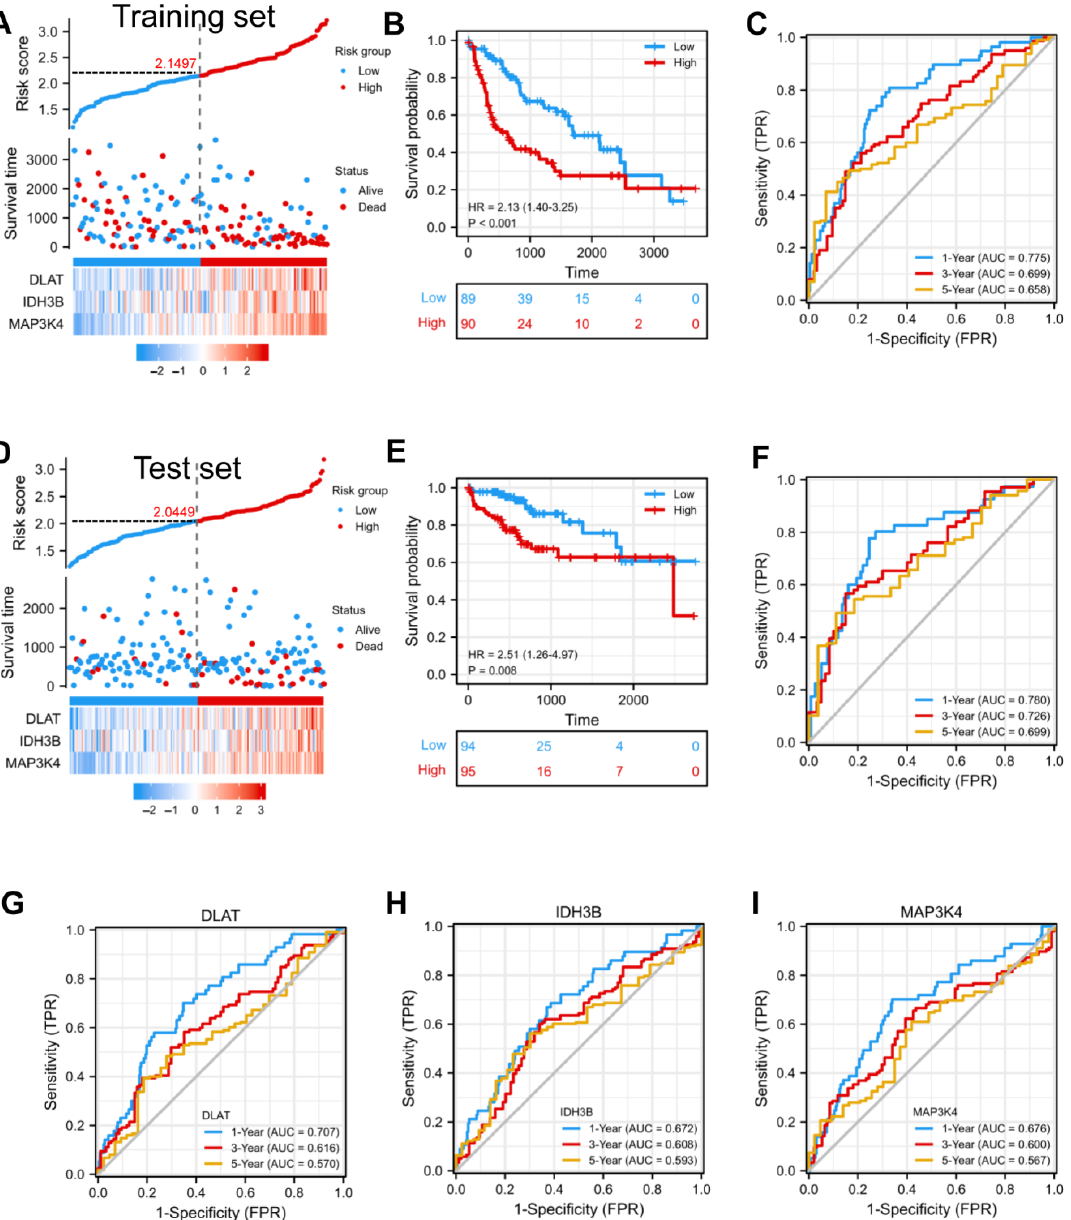
Figure 4. Construction and validation of a prognostic model. ( A ) Risk score, patient survival status, and expression heatmap of 3 DEGs in the training set. ( B , C ) Kaplan–Meier curve and time–ROC curve of risk score in the training set. ( D ) Risk score, patient survival status, and expression heatmap of 3 DEGs in the test set. ( E , F ) Kaplan–Meier curve and time–ROC curve of risk score in the test set. ( G – I ) The predictive efficiency (1, 3, and 5 years) of DLAT, IDH3B, and MAP3K4 in TCGA-LIHC.